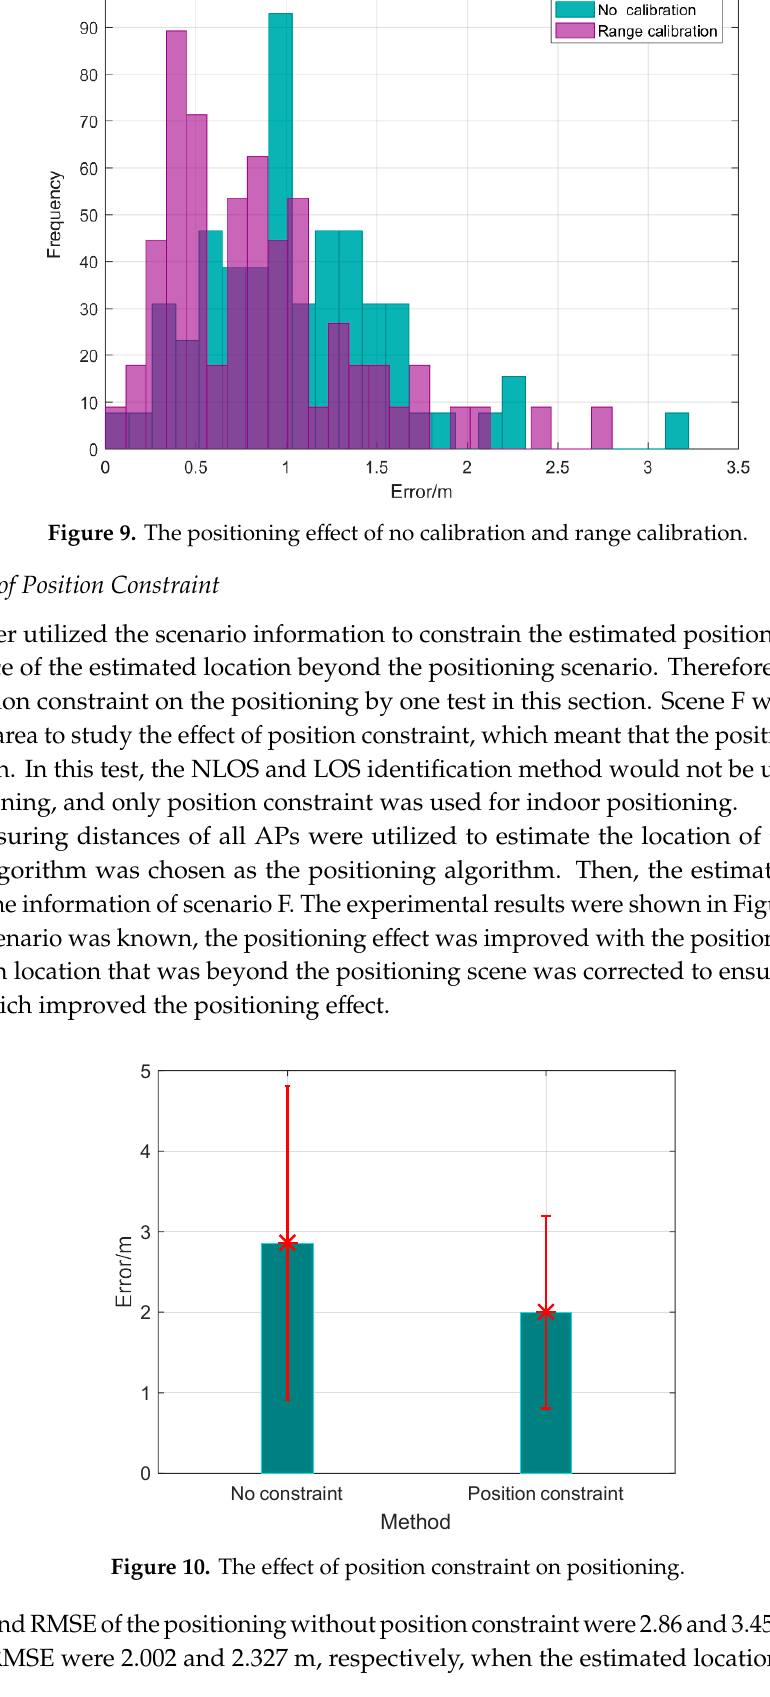
Table 1. The MEs and RMSEs of no range calibration/m.